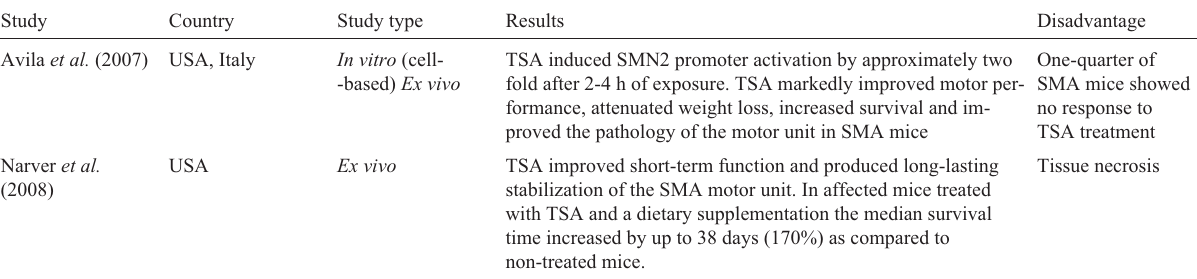
Table 7 - Summary of studies on TSA for the treatment of spinal muscular